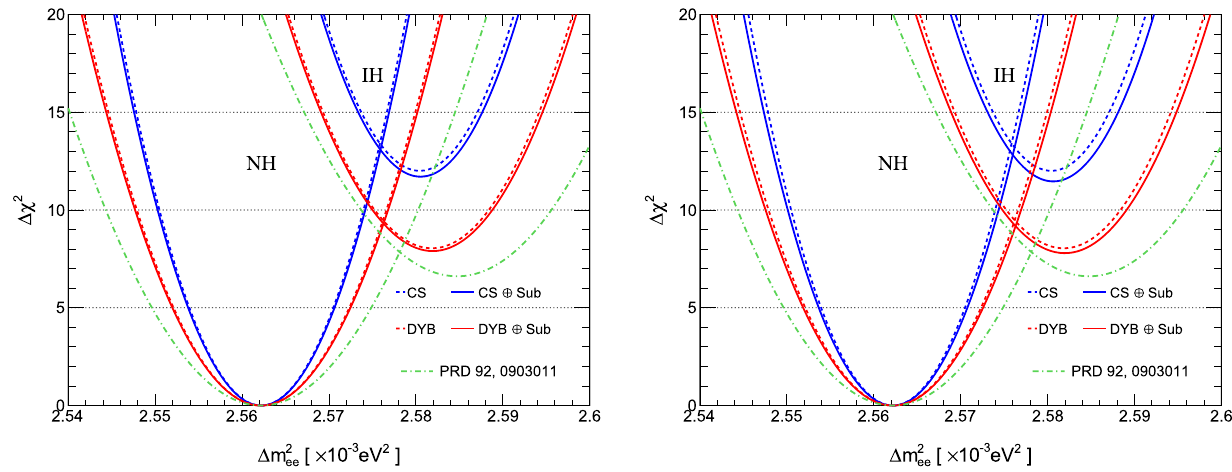
Fig. 8 Same as Fig. 5, but fine structure is estimated based on the summation spectra from the literature instead of our own generated samples. Left: Results with fine structure based on the spectrum in Ref. [25]; Right: Results with fine structure based on the spectrum from Ref. [26]